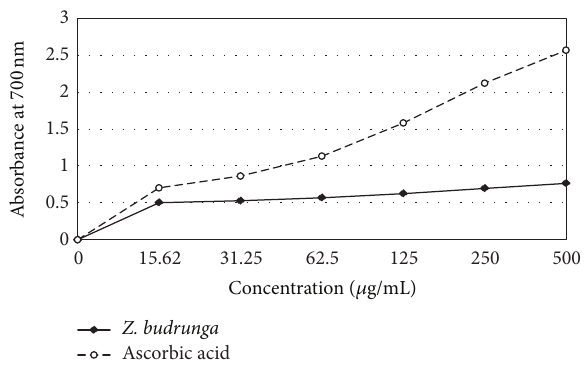
Figure 3: Reducing power of Z. budrunga seed extract.